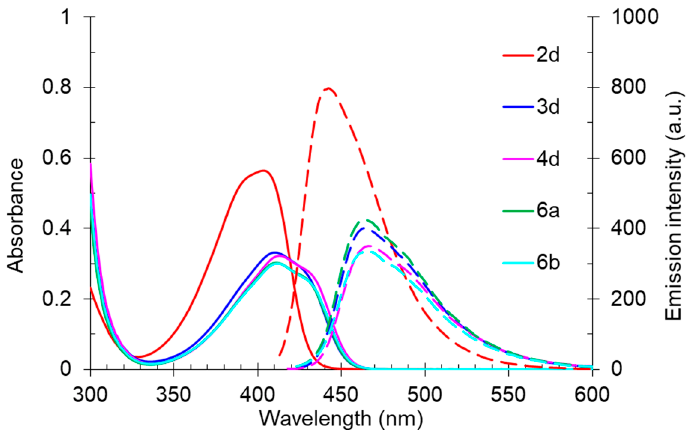
Figure 11. UV-vis absorption (5 × 10 –5 M, solid line) and emission (5 × 10 –5 M, dashed line) spectra of compounds 2d, 3d, 4d, 6a, and 6b in toluene.